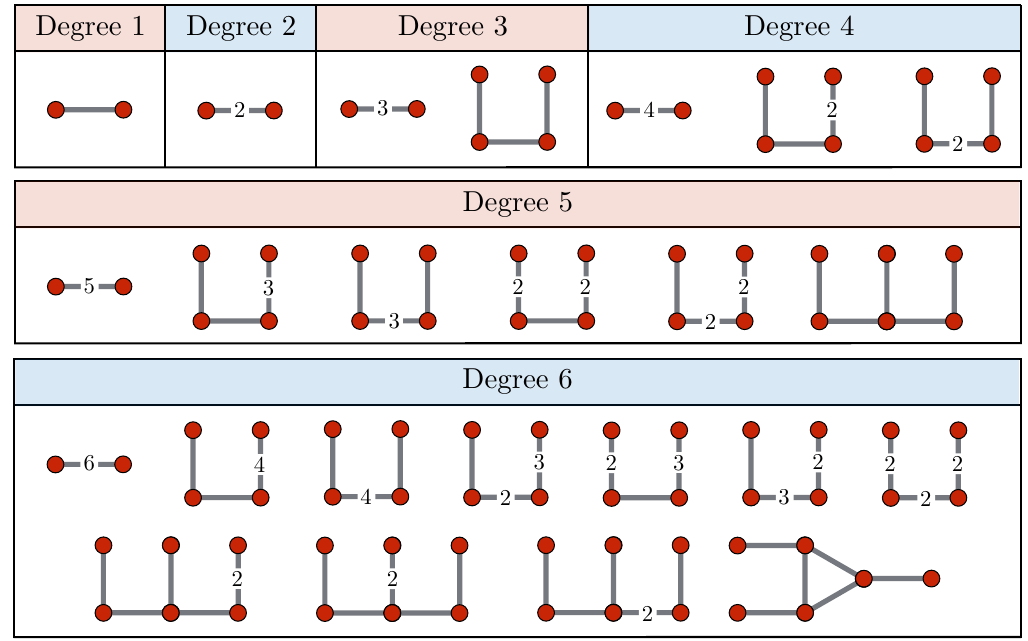
Table 9. Prime EFPs for the color-reduced basis of the 1-collinear